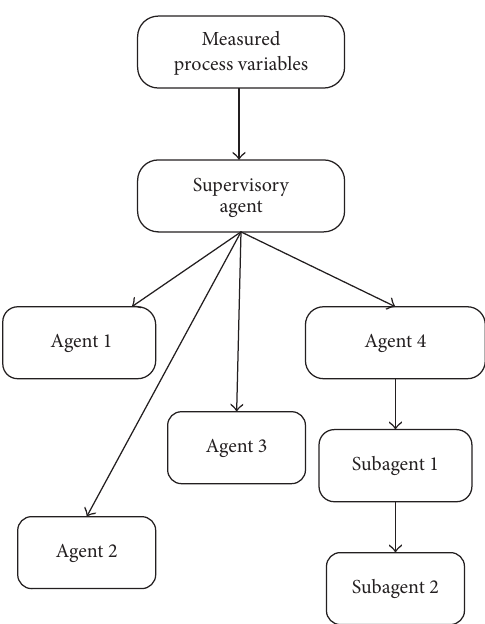
Figure 13: Schematic diagram of HDNN